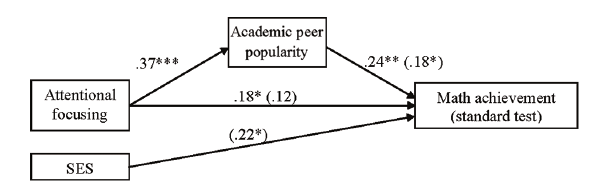
FIGURE 2 | Relational model with academic peer popularity as mediator in the AF and math achievement (teacher’s report) association. Numbers in the figure are beta coefficients ( ˆ β for mediational model are in parentheses). ∗ p < 0.05; ∗∗ p < 0.01; ∗∗∗ p < 0.001.